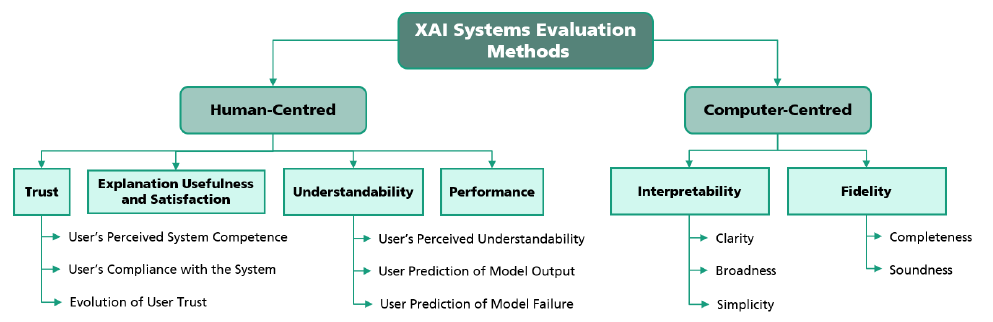
Figure 1. Proposed taxonomy for XAI systems’ evaluation